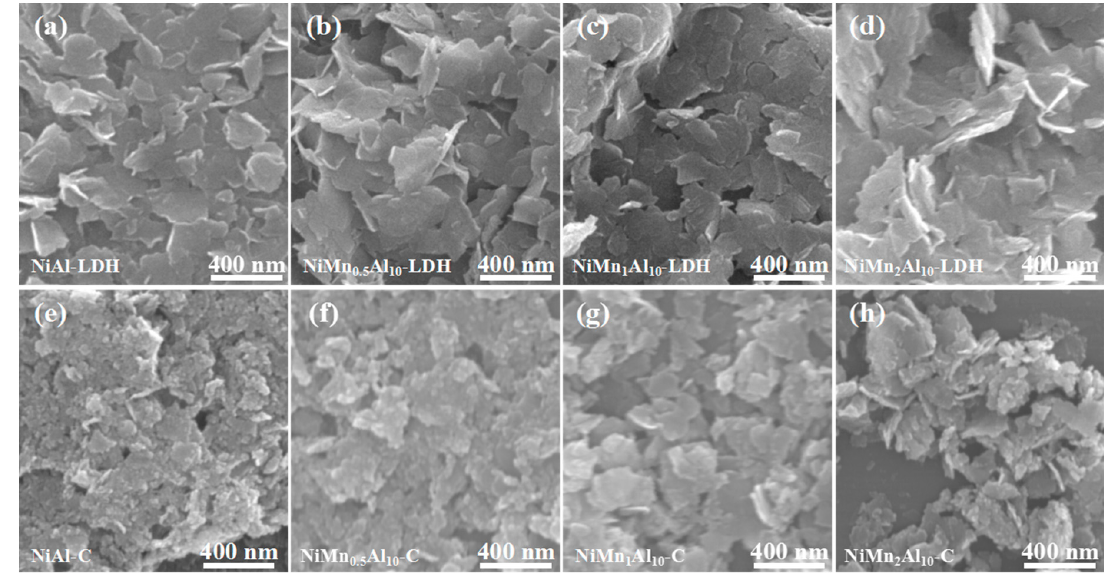
Figure 2. SEM images of the LDHs precursors ( a – d ) and the corresponding catalysts after reduction ( e – h ).